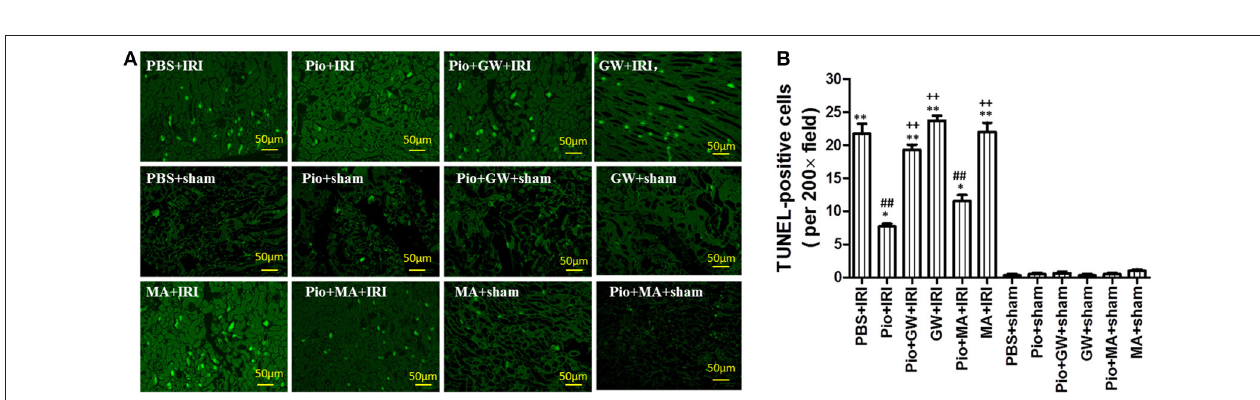
FIGURE 2 | Pioglitazone decreases cell apoptosis at 24h after renal IRI. (A) Representative photographs of kidney sections stained for apoptotic cells (green). Scale bar: 50 µ m. Original magnification: 200x. (B) Quantitative analysis of TUNEL-positive cells in the kidneys. Compared with the PBS + sham group, *represents for P < 0.05, **represents for P < 0.01; Compared with the PBS + IRI group, ## represents for P < 0.01; Compared with the Pio + IRI group, ++ represents for P < 0.01. n = 6 in each group. TUNEL, terminal transferase dUTP nick-end labeling.